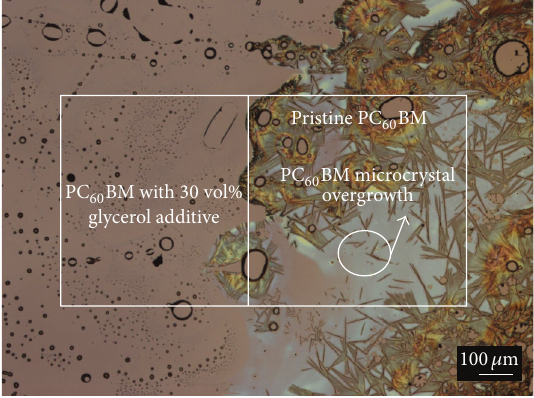
Figure 4: Optical microscope image of the split analysis, scale 100 𝜇